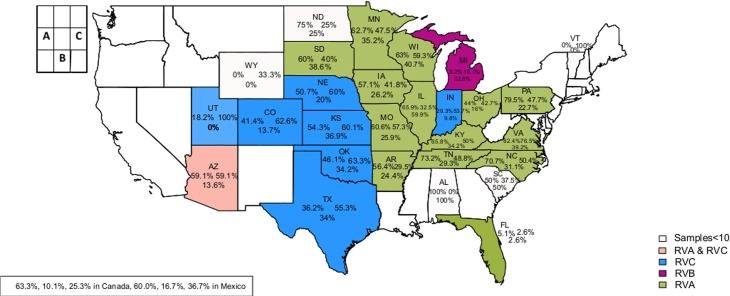
Percentages of RVA, RVB, and RVC samples by state.The color represented highest prevalence of the RV species (green represents RVA, purple represents RVB, blue represents RVC while pink represents equal percentages of RVA and RVC.